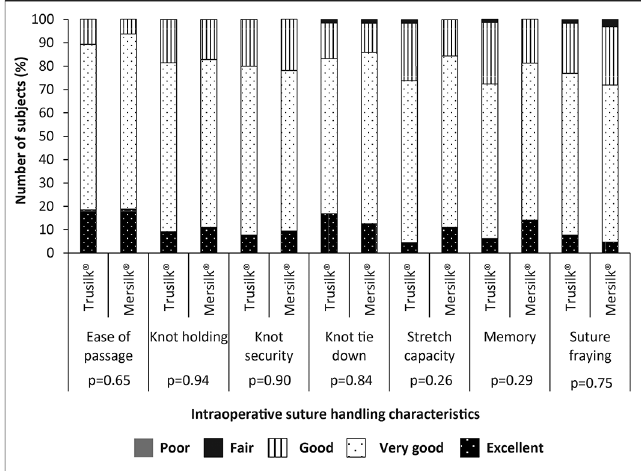
Figure 3. Intraoperative suture handling characteristics in study participants randomized to Trusilk ® (n=65) and Mersilk ® (n=64)